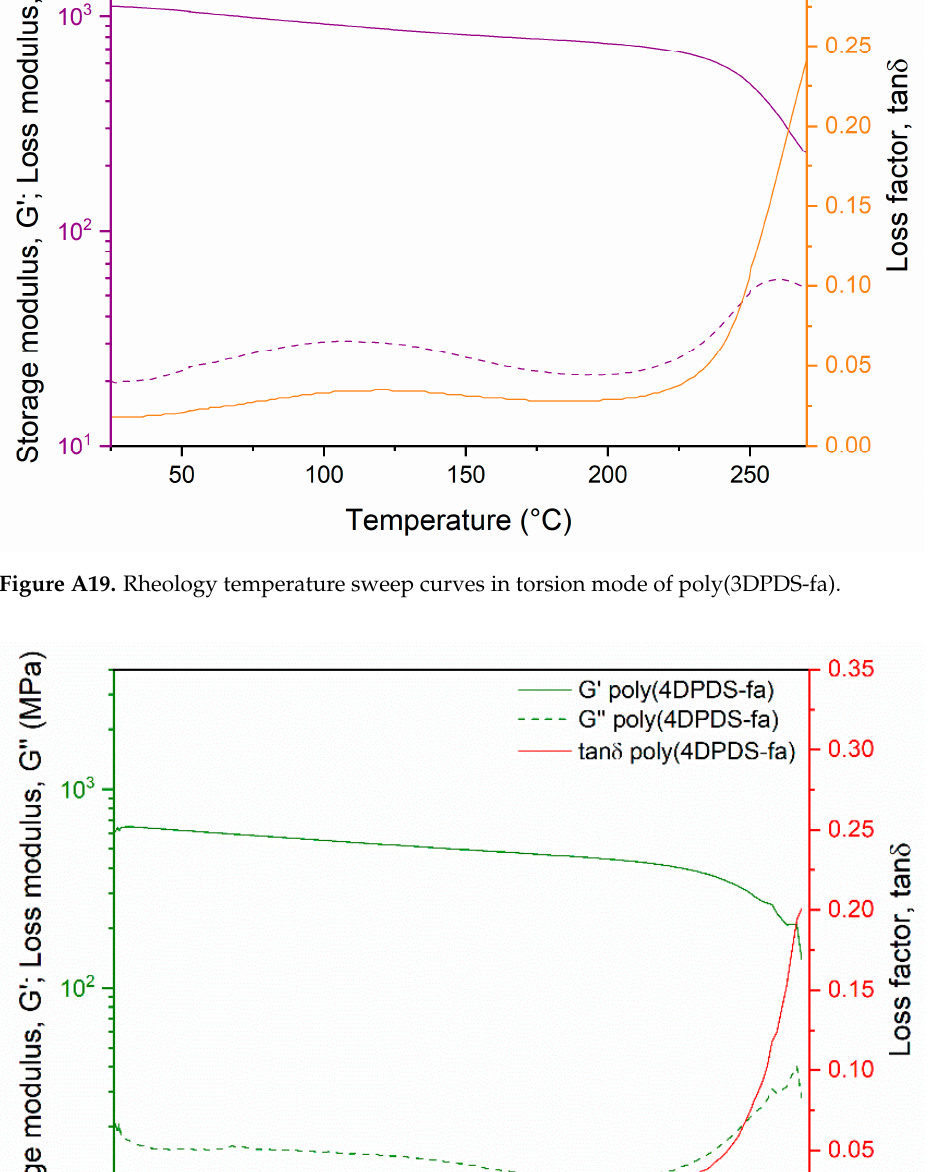
Figure A18. Curing behavior of 4DTP-fa by rheo-kinetics measurement at 150 °C over time. Full line storage modulus (G’) and dash line (G’’). Gelation points are indicated by dotted lines with arrows.